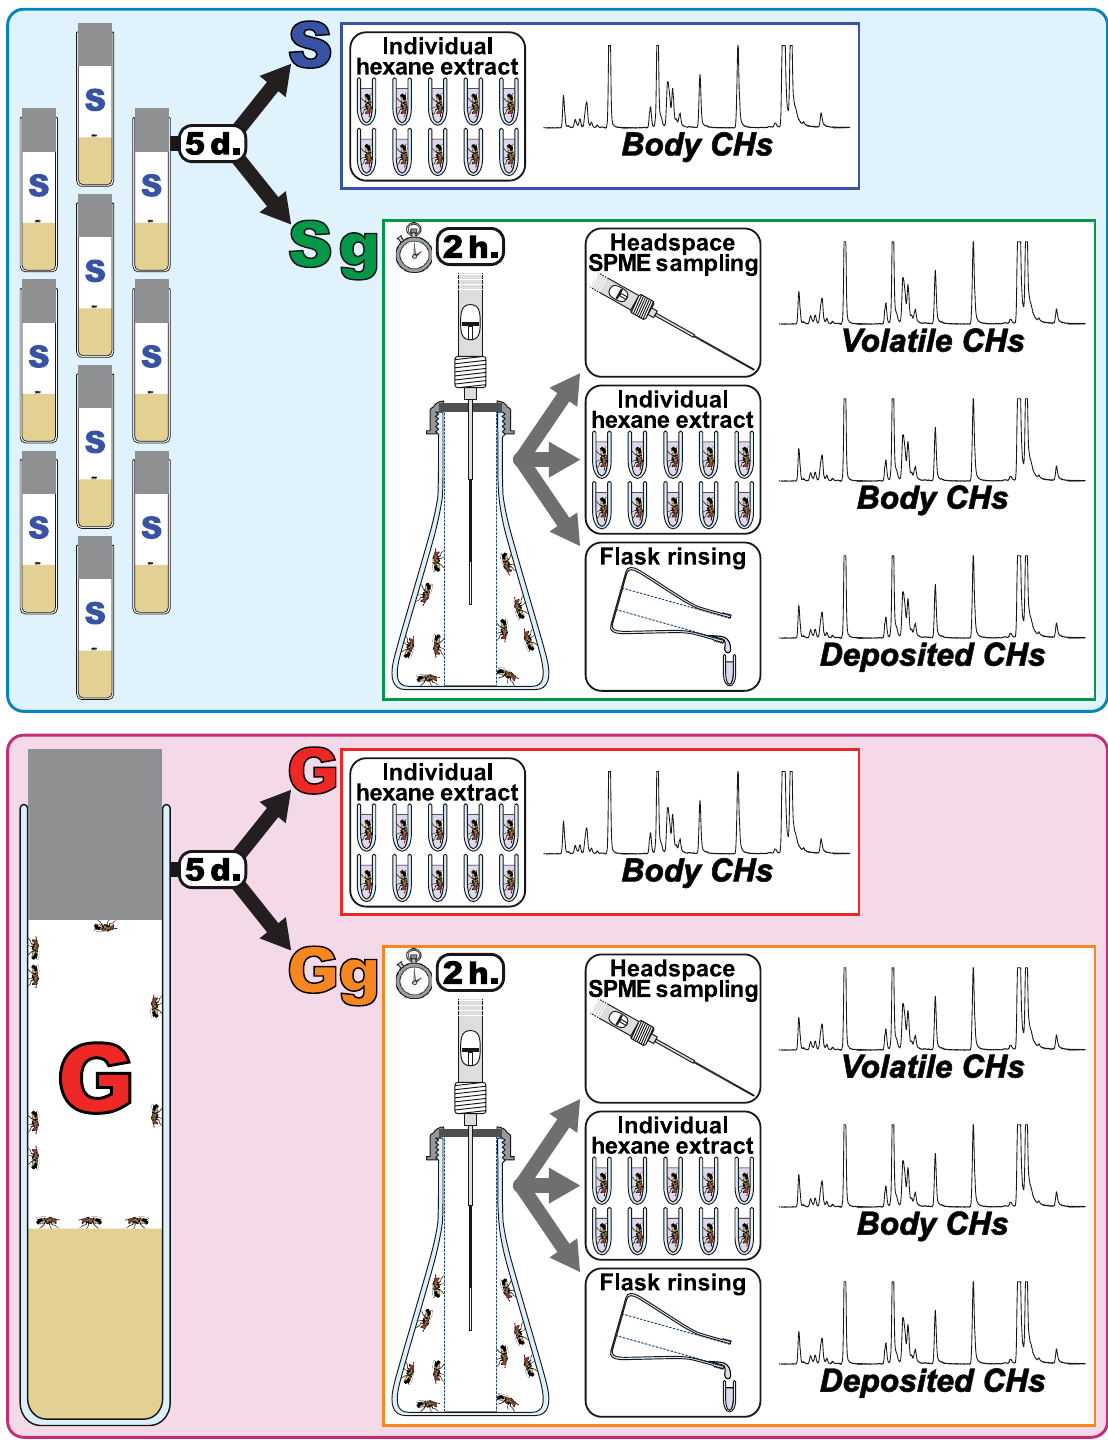
Figure 1. Experimental procedure for estimating the effects of different social experience on volatile, deposited and body CHs of adult flies. Five-day old singly reared flies (called ‘‘S’’) were either individually hexane-extracted (body CHs) or grouped for two hours for ‘‘socialization’’ (groups of 10 same-sex flies = Sg) and thereafter sacrificed for measurements. Ten G-flies were similarly treated for measurements (‘‘Gg’’ vs ‘‘G’’). During the 2-hour socialization period, Sg and Gg flies were transferred from the large vial of 100 ml in volume, in which they spent the first five days of their adult life, to a smaller chamber (8 ml of available space) fitted with a SPME fiber. This fiber allowed us to sample volatile CHs emitted by flies during the 2-hour socialization period. Thereafter, Sg- and Gg-flies were individually hexane-extracted (body CHs), and the flask was hexane-rinsed (deposited CHs).